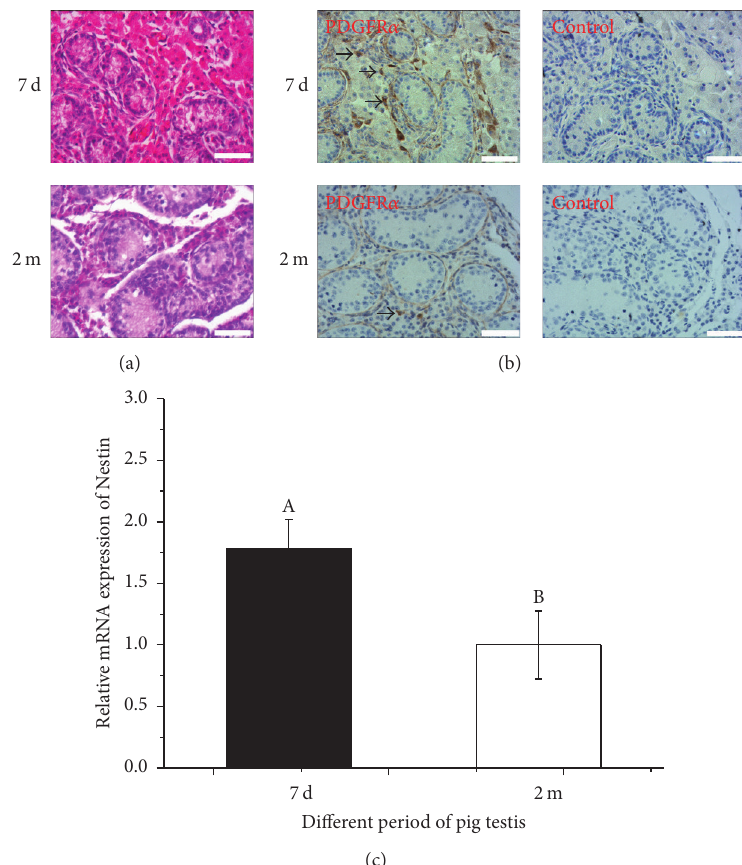
Figure 1: Identification of pig stem Leydig cells (SLCs) in situ. (a) H&E staining of 7 days’ and 2 months’ old porcine testes (bar = 50 𝜇 m). (b) Immunohistochemical analysis of PDGFR 𝛼 of 7 days’ and 2 months’ old porcine testes (bar = 50 𝜇 m); the black arrowheads indicated the PDGFR 𝛼 -positive cells in testicular interstitium. (c) mRNA expression of Nestin in 7 days’ and 2 months’ old pig testes. Different letters (A, B) indicate significant difference ( 𝑃 < 0.05